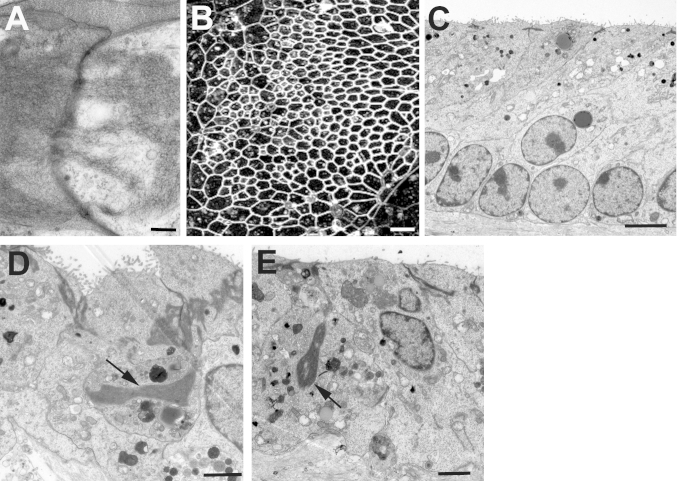
Junctional actin assemblies in mouse. (A) Rapidly frozen (by high pressure freezing), freeze-substituted tissue shows electron-dense structures in contact with the lateral membrane in the region of the adherens junction are composed of microfilaments. (B) Explanted utricular macula from a 22-month-old CBA/Ca mouse, maintained in culture for 19 days after exposure to gentamycin. All hair cells lost. Phalloidin labeling of whole mount preparation shows actin bands in the junctional region of supporting cells to be relatively thin, but more prominent than in the equivalent junctional complexes of the cells in the surrounding nonsensory epithelium. (C–E) Thin sections of utricle from a 22-month-old CBA/Ca mouse maintained in culture for 6 days after exposure to gentamicin; hair cells lost. (C) The adherens junctional region between supporting cells is simple; there is little evidence large actin assemblies. (D, E) Electron-dense structures with the appearance of junctional actin assemblies are displaced to the basal region of the cells (arrows) and detached from the plasma membrane (E). Scale bars: (A) 0.5 μm; (B) 10 μm; (C) 5 μm; (D, E) 2 μm.